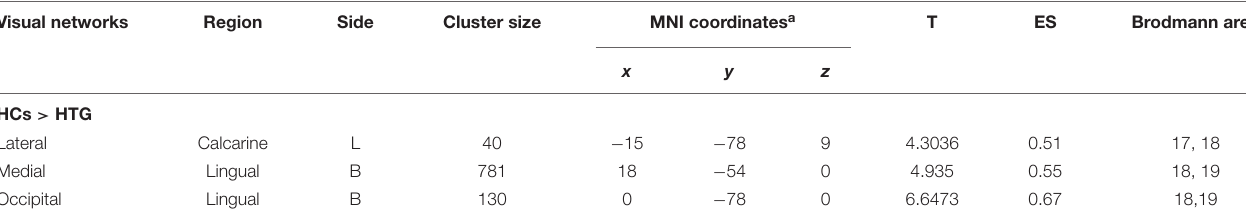
TABLE 2 | Regions exhibited altered functional connectivity within the visual networks in healthy controls as compared to high-tension glaucoma patients. Visual networks Region Side Cluster size MNI coordinates a T ES Brodmann area x